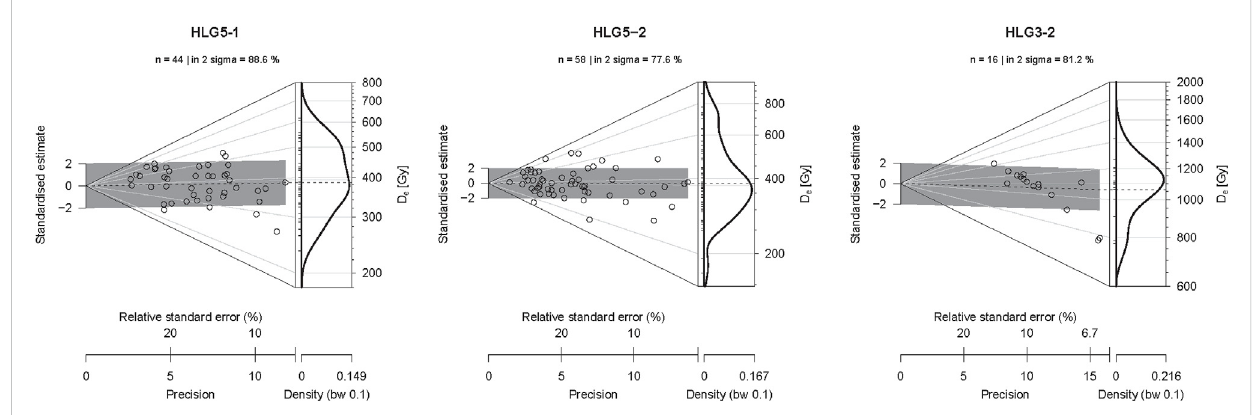
FIGURE 5 D e distribution of KF samples measured with single-grain (HLG5-1 and HLG5-2) and single aliquot